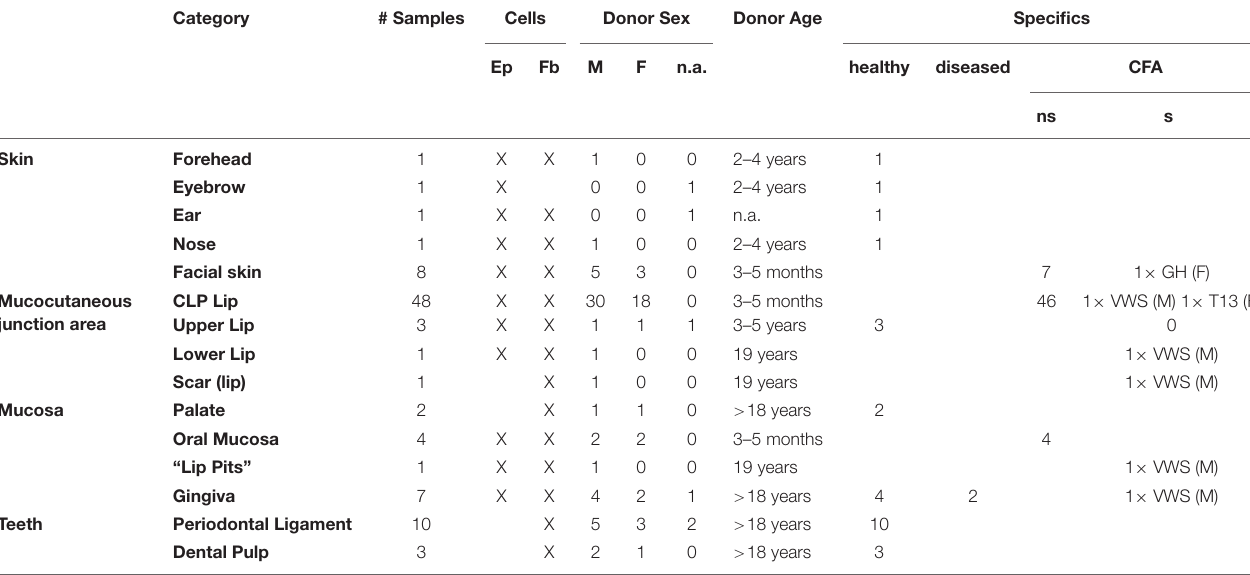
TABLE 1 | Total status of our cell bank, including the tissue category, number of samples, cell types that have been successfully isolated, donor sex and age as well as disease status (specifics). Category #